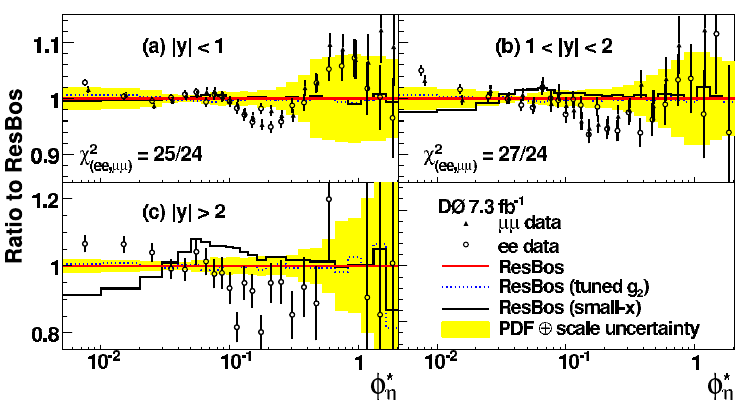
Fig. 1. Ratio of the corrected distributions of (1 /σ ) ( d σ/ d φ ∗ ) to R es B os for three rapidity intervals. For the first two rapidity intervals, η × both dielectron and dimuon data are presented. Comparison is also made to a variety of R es B os models. Di ff erences between data and predictions are observed, and in particular R es B os with small- x broadening is disfavoured.